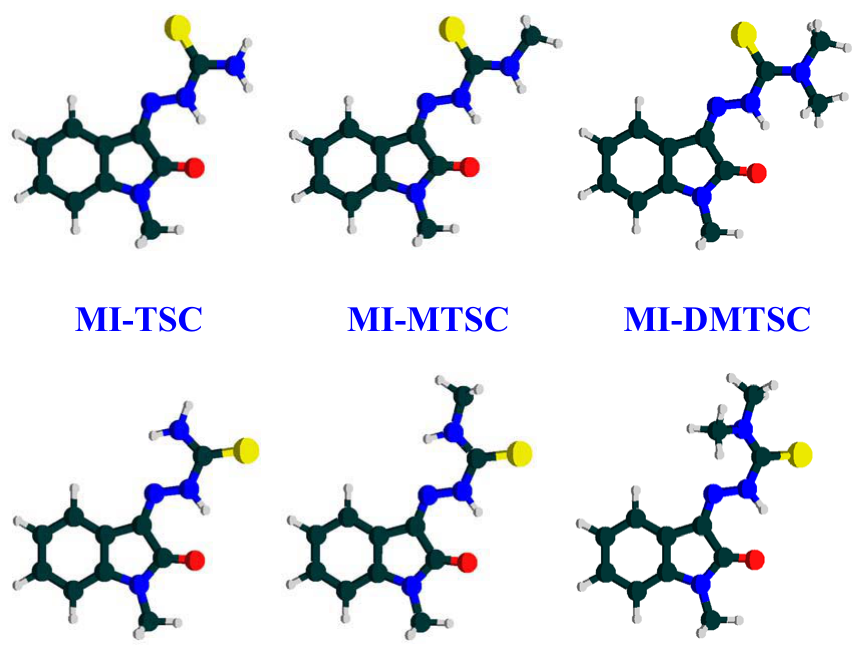
Fig. 3 Optimized structures of 1-methylisatin-based thiosemicarbazones.